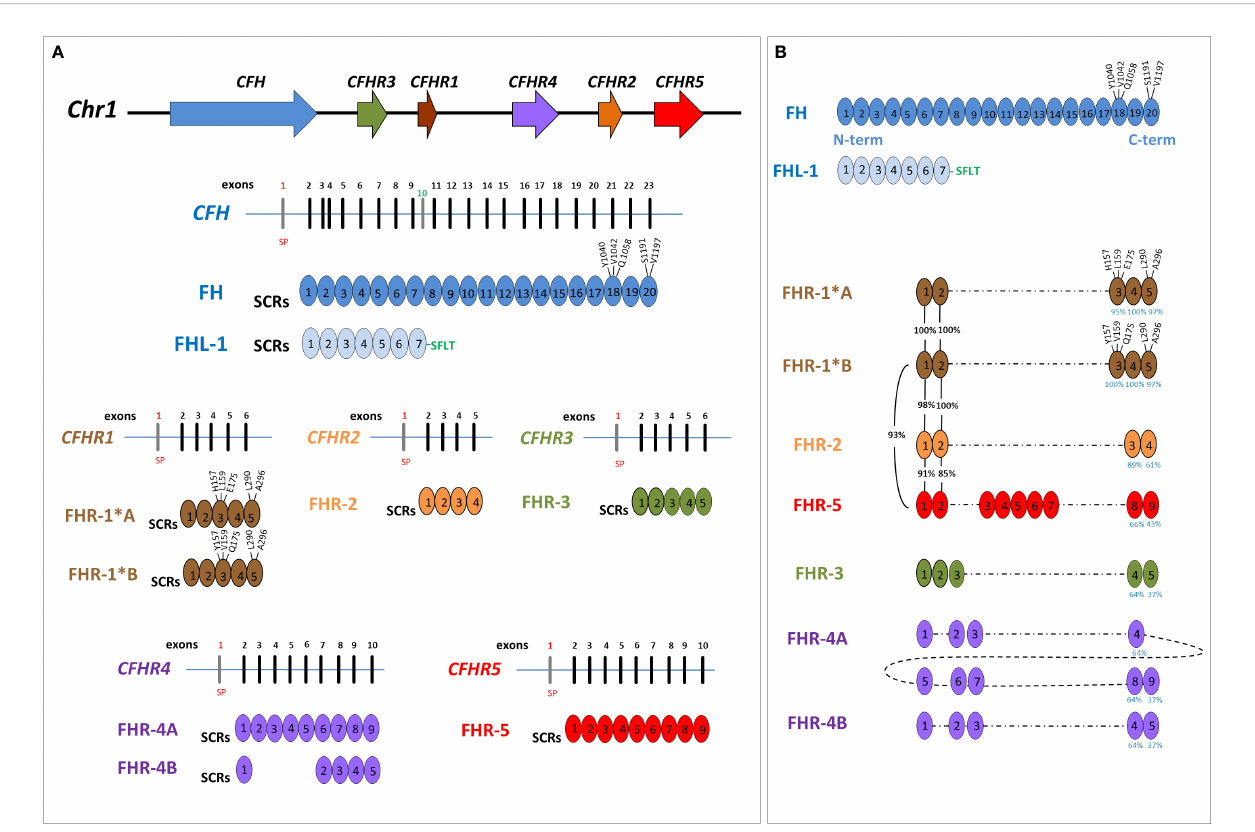
FIGURE 1 Structure of Factor H family: genes and proteins. (A) The human complement factor H ( CFH ) gene family is located on chromosome 1q31.3 and includes six genes: CFH, CFHR3, CFHR1, CFHR4, CFHR2 and CFHR5 . For each gene, the corresponding protein was represented. Each short consensus repeat (SCR) is composed of about 60 amino acids and is encoded by a single exon, with the exception of SCR2 of Factor H (FH), encoded by exon 3 and 4. Exon 1 of each gene encodes 18 amino acids of the signal peptide (SP). CFH gene is composed of 23 exons and, through two alternative splicing, produces FH, deriving from 22 exons, and Factor H-like protein 1 (FHL-1), deriving from 10 exons. Exon 10 is not included in the FH transcript and encodes the C-terminal four amino acids (Ser-Phe-Leu-Thr; indicated in the Figure with the green SFLT) and the 3 ’ UTR of FHL-1. FHR-1 exists in two isoforms that differ in three amino acids in the SCR3: FHR-1*A is known as acidic isoform and has His at position 157 (H157), Leu at 159 (L159) and Glu at 175 (E175); FHR-1*B is the basic isoform with Tyr at position 157 (Y157), Val at 159 (V159) and Gln at 175 (Q175). (B) Factor H-related proteins (FHRs) share a high degree of conservation within the C-terminal domains of FH (SCR18-SCR19-SCR20), and FHR-1 is the most similar (the percentage of amino acids identity between each SCR of FHR and those of FH is indicated by blue numbers under the SCRs). As represented in the Figure, SCR3 of FHR-1*A differs from SCR18 of FH for 3 amino acids (H157, L159 and E175) while SCR5 differs from FH-SCR20 for 2 amino acids (L290 and A296). At variance, SCR3 of FHR-1*B has the same amino acids of SCR18 of FH. Of note, the N-terminal domains of FHR-1, FHR-2 and FHR-5 (SCR1 and SCR2) have a high sequence identity (indicated by black percentage numbers) and include a dimerization motif which explains their presence in plasma as either homo-or heterodimers. This image was inspired by Jozsi et al. (7) Trends immunology,